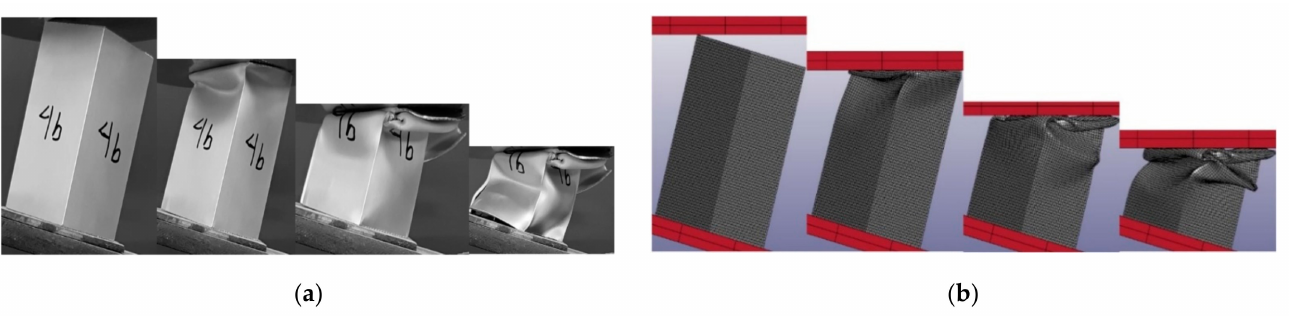
Figure 14. Plastic deformation progress of 15 ◦ crushing angle for edged oblique impact. ( a ) experi- ment; ( b ) simulation.